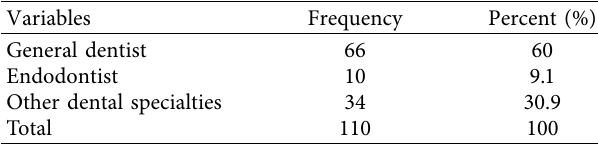
Table 2: Frequency of dental specializations.